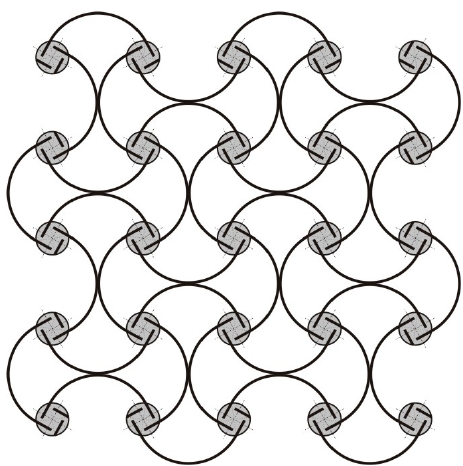
Figure 9. Occurrence of a maximal angle of nodal rotation, θ m , in the antichiral thermomechanical metamaterial of Figure 1 type. This angle can be determined from a condition that the deformed distance (7) between two nodes is equal to a double distance between the middle arch point of a bimetal strip, attached to these nodes, and the base line passing through the centers of these nodes. The usual thermal expansion has a